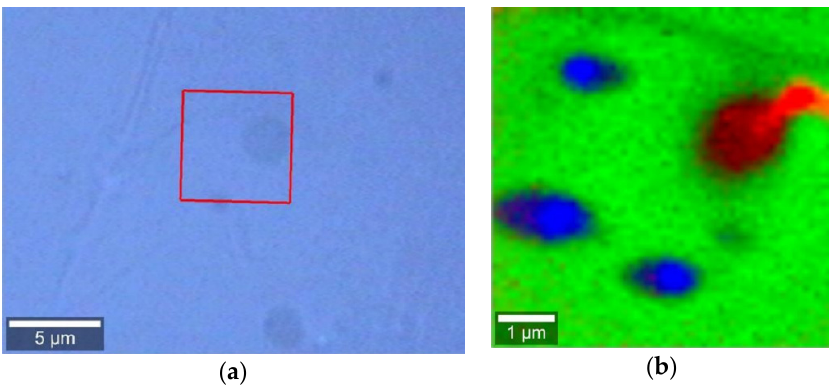
Figure 5. ( a ) The red box denotes an area of PET surface defect by salmon muscle adhesion. This section has been magnified in ( b ); ( b ) Raman image with phase changes in the area of adhesion.